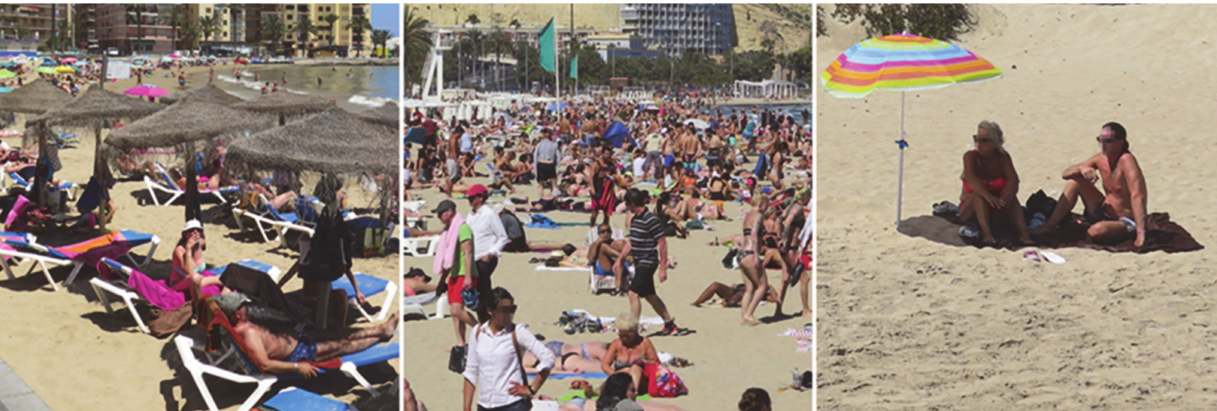
Figure 3. Three Mediterranean urban beaches located in the province of Alacant. In each shot, there are smoking